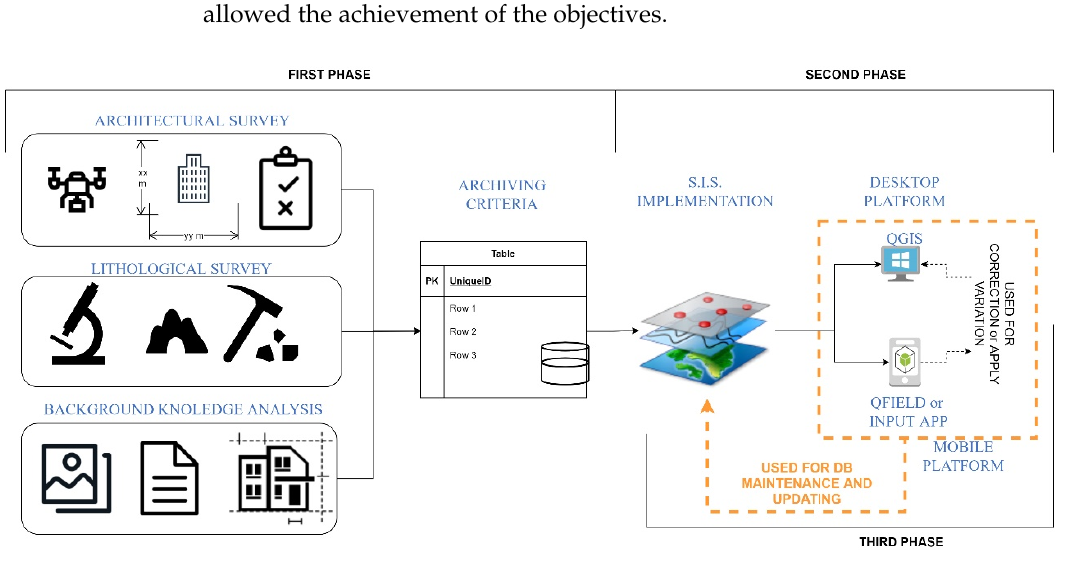
Figure 2. General workflow schema.